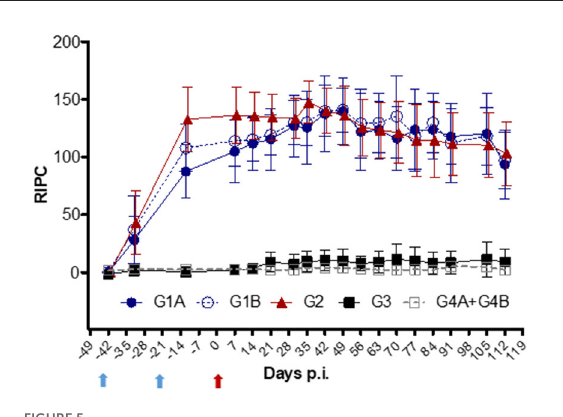
FIGURE5 Kinetics of anti- T. foetus IgG levels measured by ELISA in sera. Immunized/challenged groups: Trichobovis via subcutaneous (SC; G1A) or intravulvar (IVU; G1B) routes, TrichGuard by SC route (G2). Non-immunized/challenged animals (G3) and non-immunized/non-challenged (G4A + G4B) groups. All challenged cows were inoculated intravaginally with 2 × 10 6 T. foetus trophozoites and non-challenged cows with PBS. The average IgG levels measured throughout the experimental time (X-axis; days p.i.) are represented in the graph using the relative index percent (RIPC) value (Y-axis). Error bars represent the standard deviation. Cows were vaccinated with two doses at 21-day intervals. Blue arrows highlight the day for immunization I (day − 42) and the booster (day − 21), and the red arrow highlights the day of the challenge (day 0).